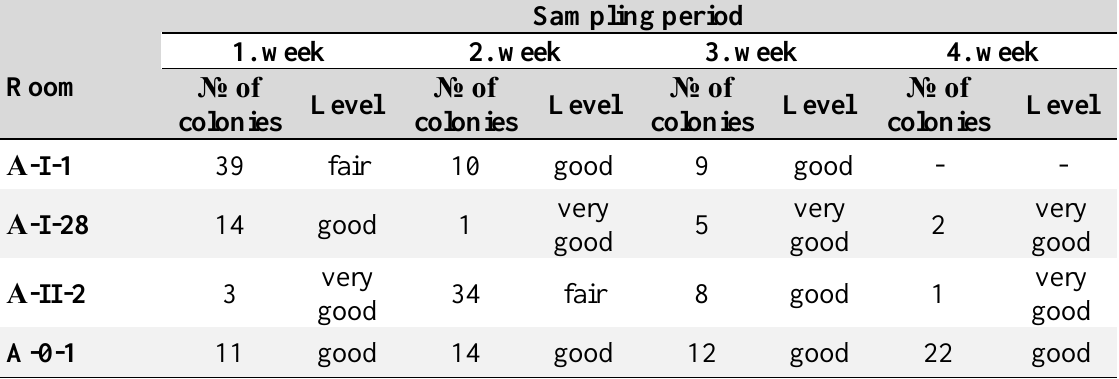
Table 4. The index of microbiological air contamination during the month of